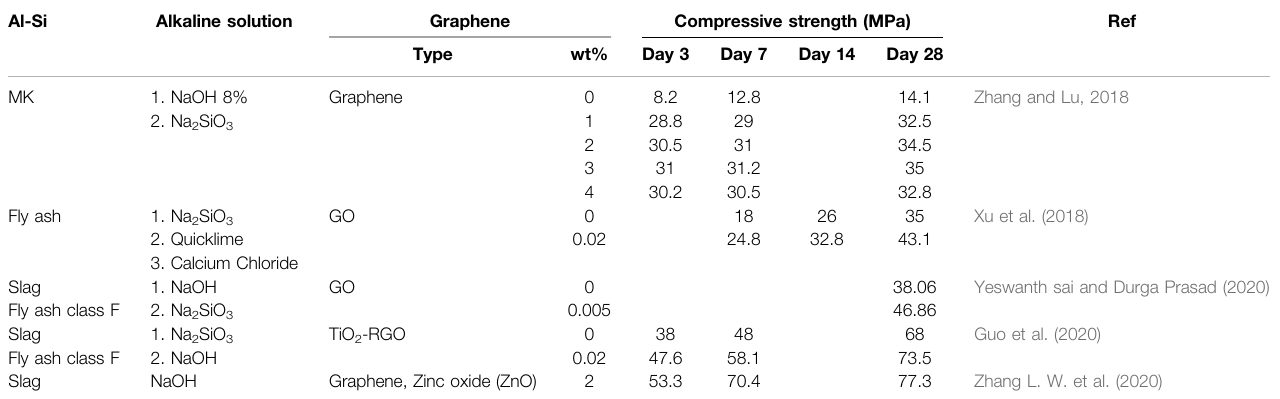
TABLE 1 | Compressive strength of various Graphene Reinforced Geopolymer Nanocomposites.